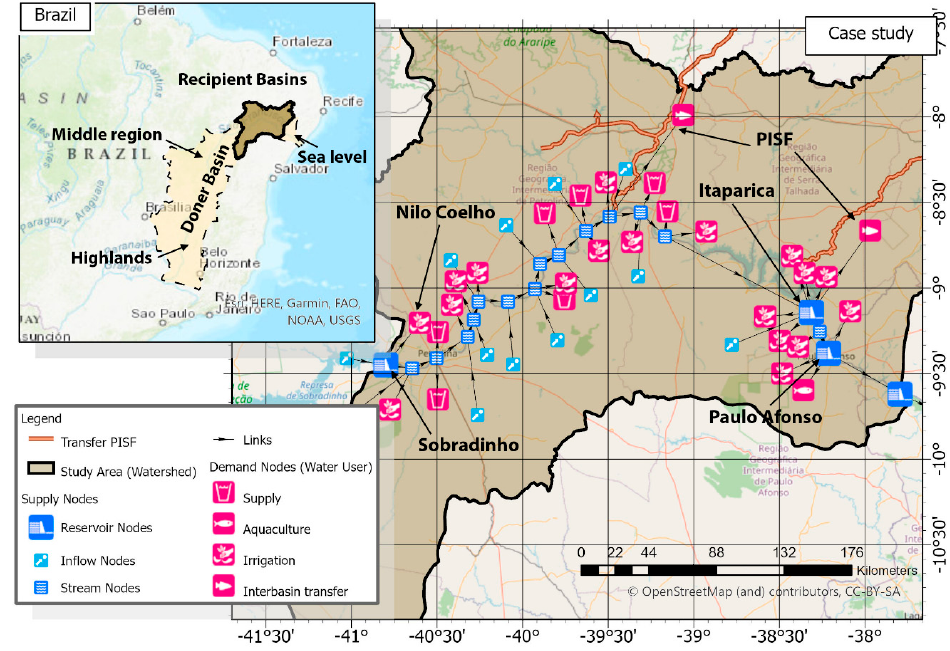
Figure 3. Case study with supply and demand nodes (using the print option of HEAL System).